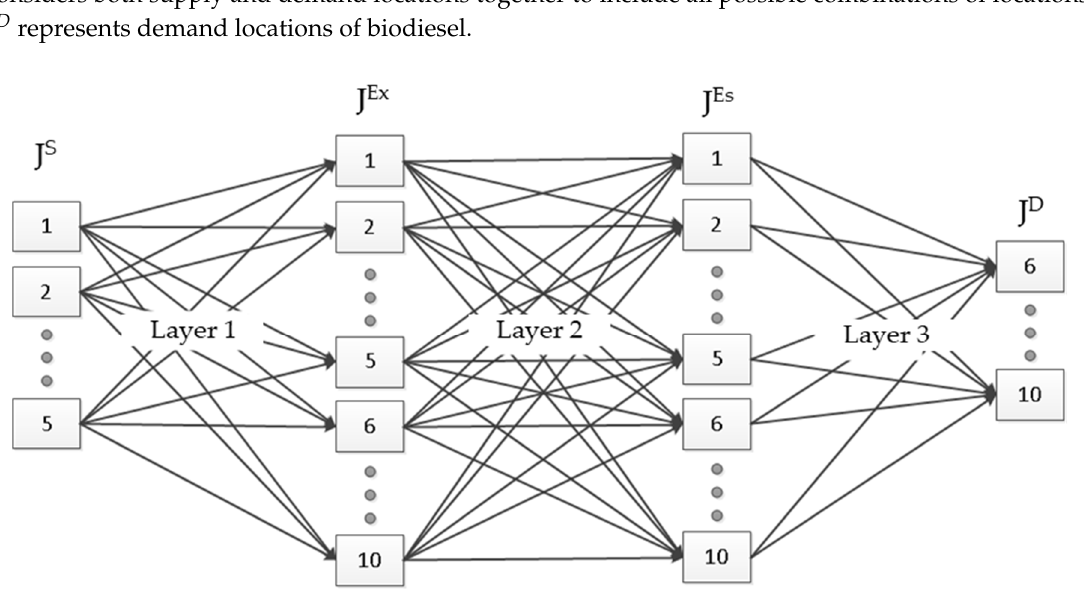
Figure 4. Network flow topology.